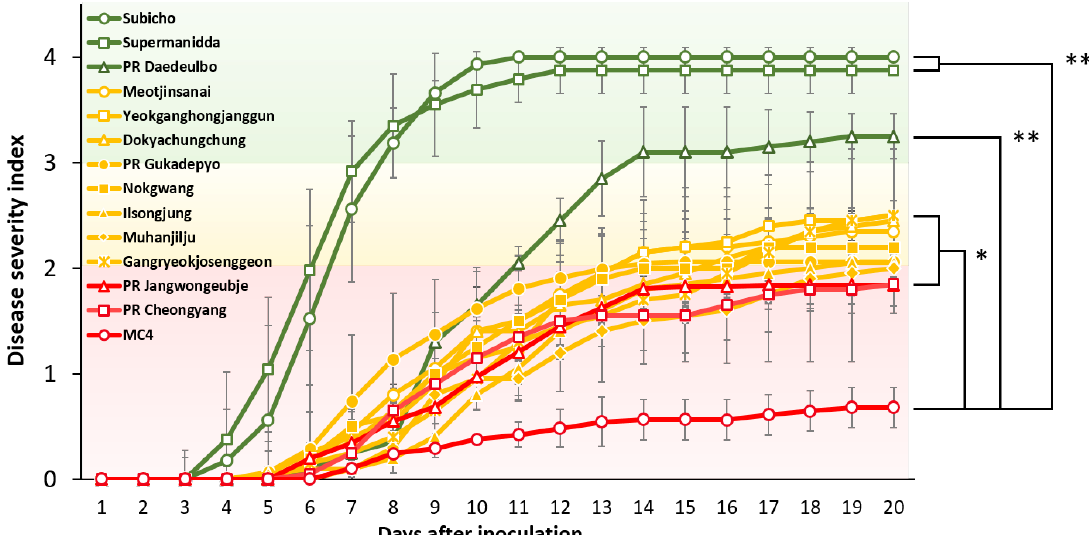
Figure 5. Disease progression through leaf to whole plant spread bioassay (LWB) in 12 pepper accessions. The eight-leaf stage seedlings were inoculated with R. solanacearum SL1931 with bacterial suspensions 1 × 10 6 CFU/mL to give inoculum volume of 0.1 mL/leaf. A line graph area of red, yellow, and green indicated resistance (R), moderate resistance (MR), susceptible (S), and the color of line was expressed the same as the areas based on the DSI score of the bacterial wilt on 20 dai for each cultivar. Each data point represents the mean disease index from at least two independent experiments. Each bar represents the S.E from three independent experiment with 24 plants. Asterisks indicate statistically significant differences (* p < 0.05 , ** p < 0.01 , *** p < 0.001 ) in AUDPC (0 to 15d), according to Student’s t-test with ‘MC4′. Table 1. BW phenotype of LWB in 12 commercial chili pepper cultivars to R. solanacearum.